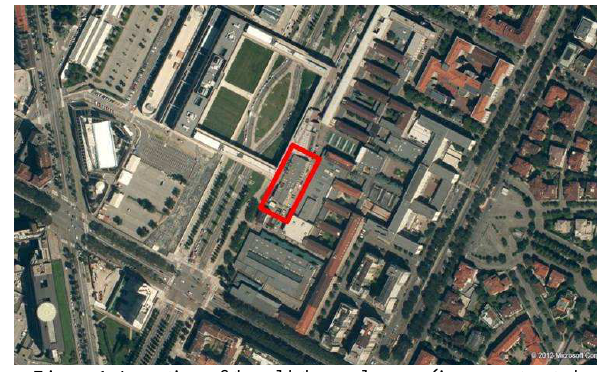
Figure 1. Location of the old thermal power(image extracted from Google Maps)